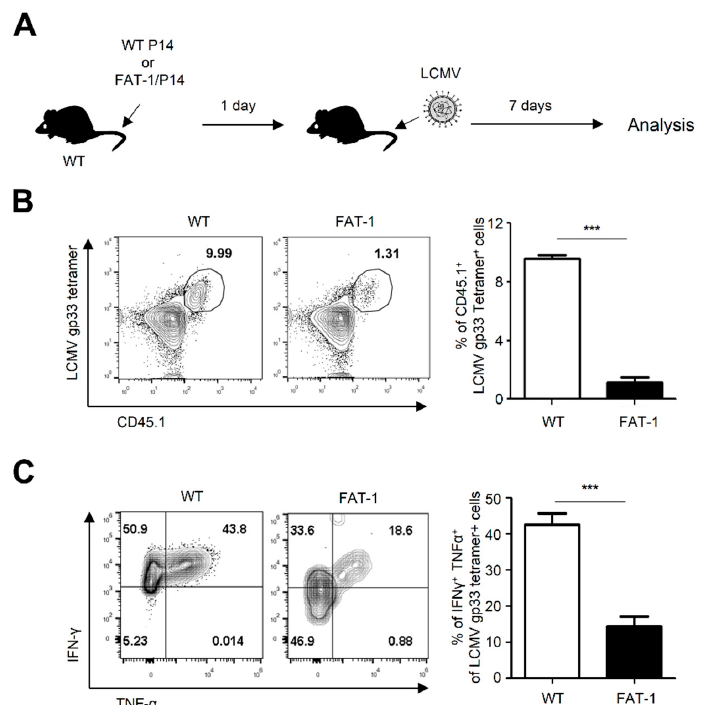
Figure 6. FAT-1 / P14 CD8 + T cells exhibited less proliferation and cytokine production than WT P14 cells. ( A ) WT P14 and FAT-1 / P14 cells were adoptively transferred into naïve WT mice, followed by infection with LCMV (Armstrong) for 7 days. ( B ) Splenocytes were stained LCMV GP33 tetramer / CD45.1 antibody and analyzed by flow cytometry. ( C ) Splenocytes were stimulated with LCMV GP33 peptide to analyze the numbers of IFN- γ - and TNF- α -producing CD8 + T cells using flow cytometry. The representative flow cytometry plots were shown in left panels and the bar graph indicates the percentages of IFN- γ - and TNF- α -producing CD8 + T cells (right panels). The data represent the mean ± SEM ( n = 5 mice per group). *** p ≤ 0.001. The data represent the results of at least three independent experiments.